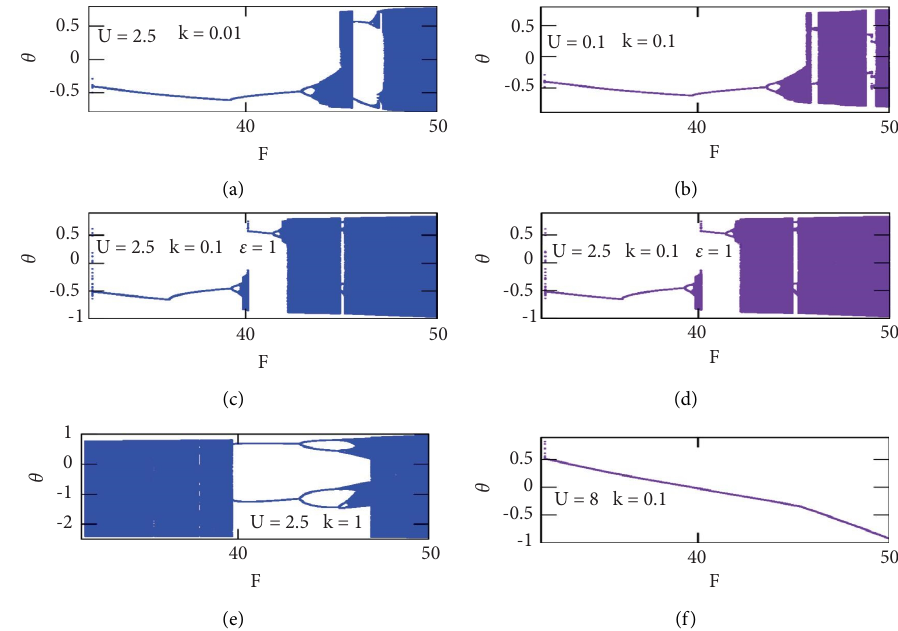
Figure 7: Effect of the parameters K and U on the bifurcation diagram for ϵ � 1 ; α � 10 ; β � 1 ; Ω � 2 ; C